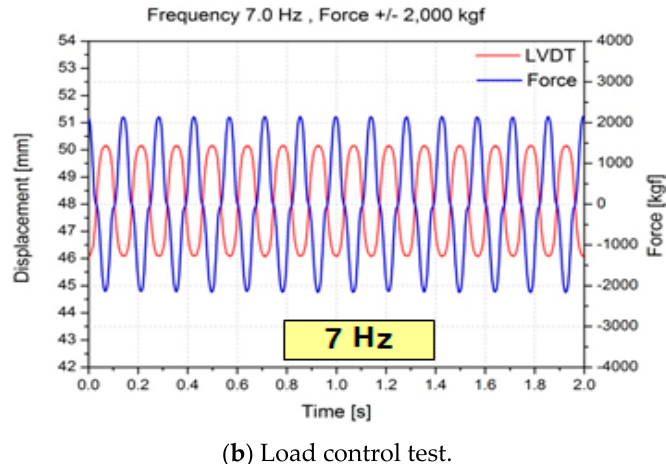
Figure 13. Results of hydraulic servo actuator according to the frequency change of the power control device.